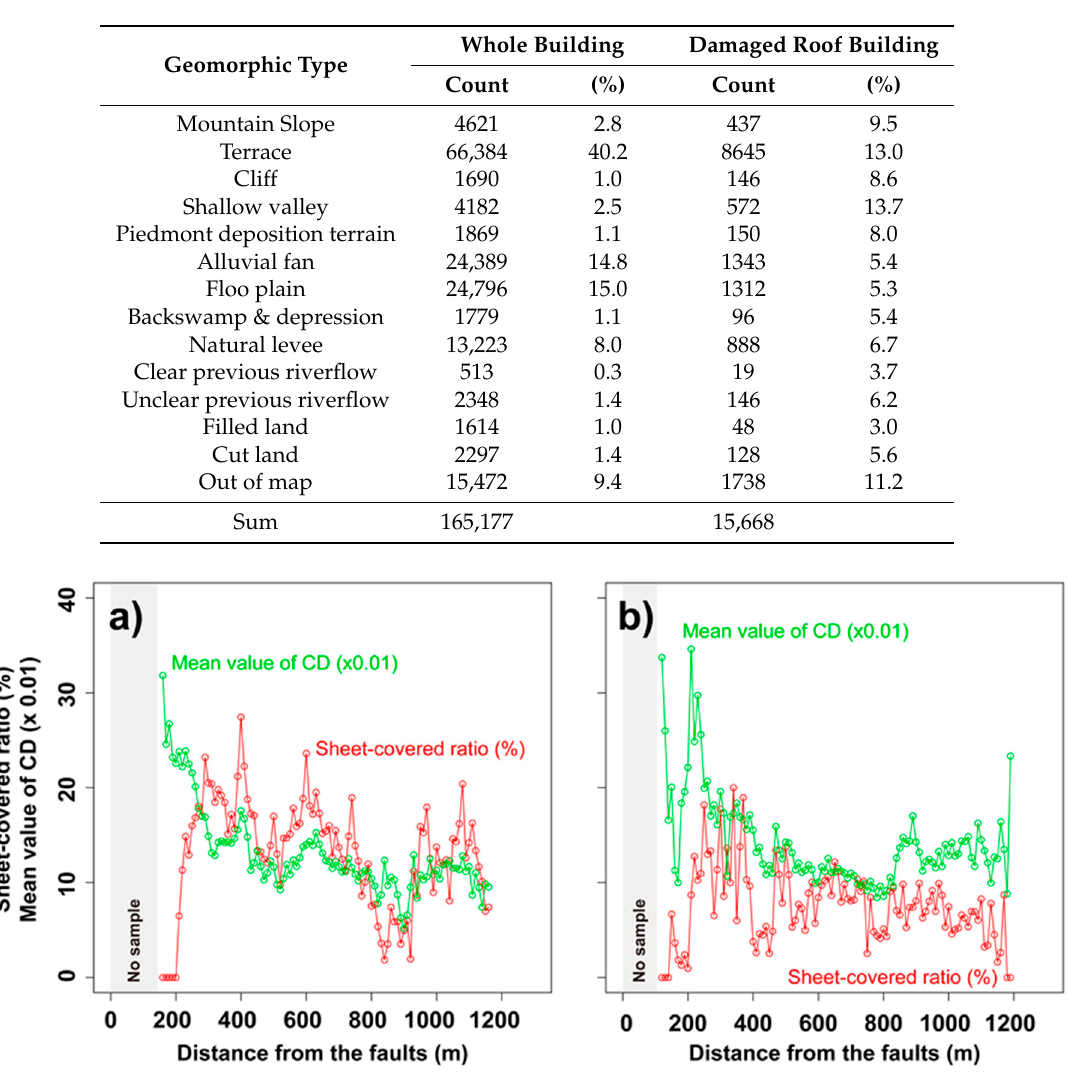
Figure 6. Variations of sheet-covered ratio and mean value of CD corresponding to the distance from the main faults are summarized for ( a ) the geomorphological majority of “Terrace” and ( b ) the geological majority of “Late Pleistocene to Holocene marine and non-marine sediments”.